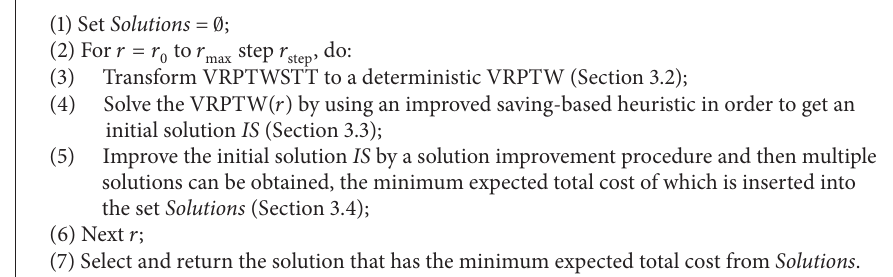
Algorithm 1: Main framework of the suggested heuristic TSH.